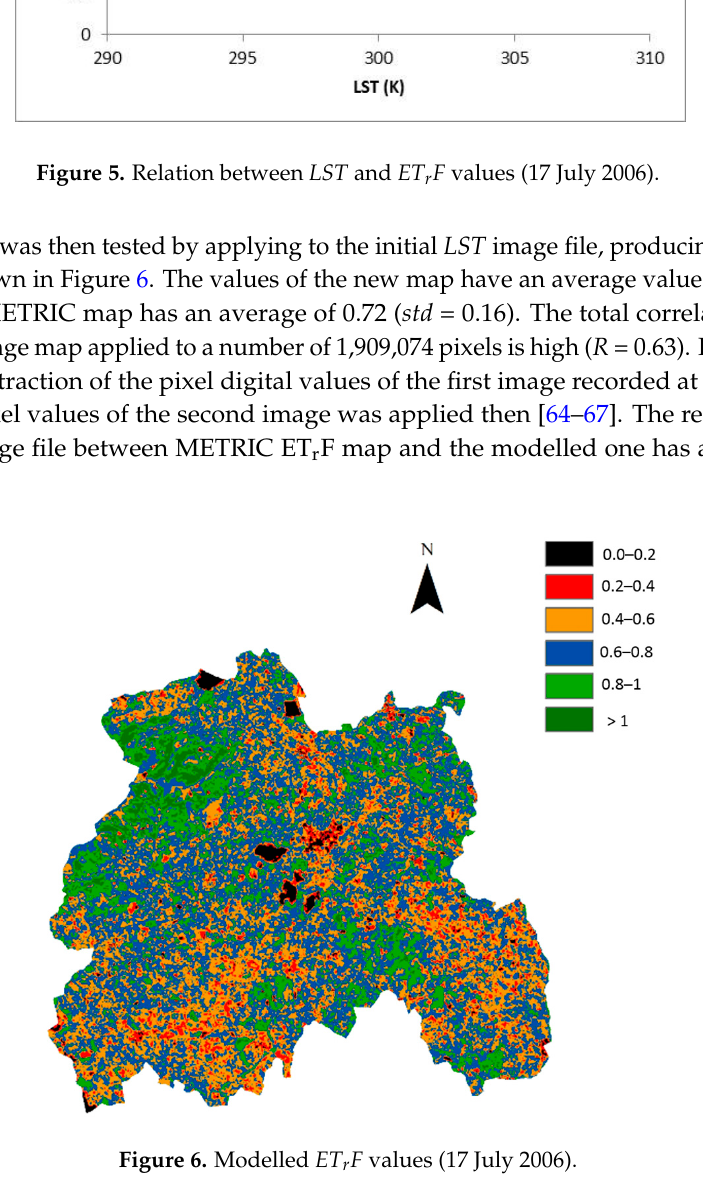
Figure 5. Relation between LST and ET r F values (17 July 2006).